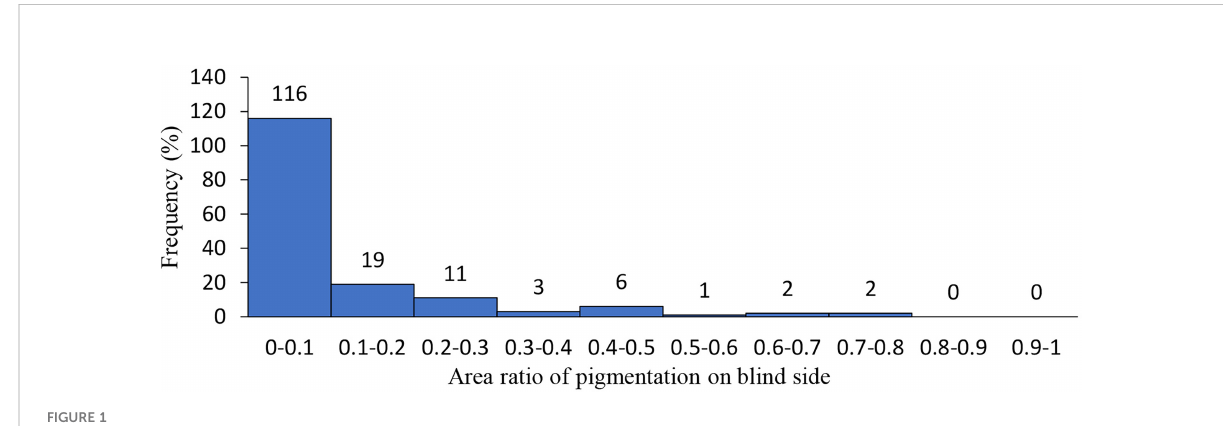
FIGURE 1 Distribution of hypermlanosis area in Chinese tongue